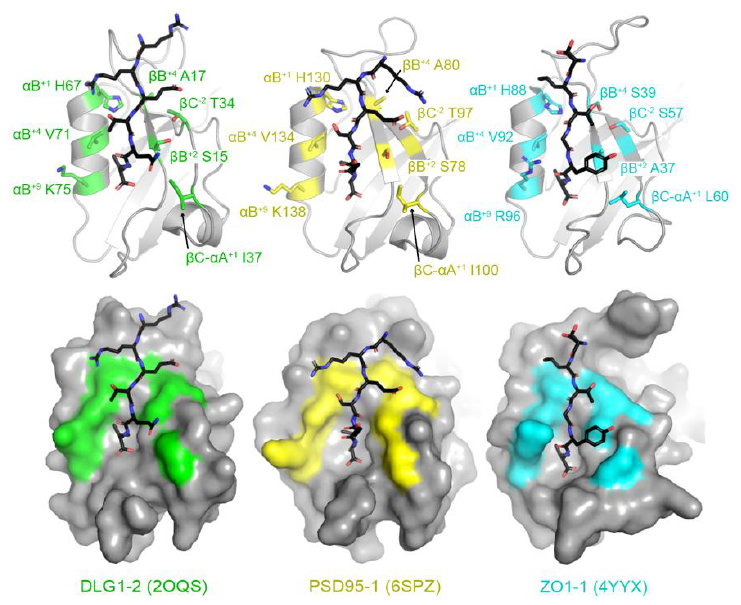
Figure 2. Identification of peptide-binding cleft residues in DLG1 PDZ2 (or DLG1-2, PDB ID 2OQS, green), PSD95-1 (6SPZ, yellow), and ZO1-1 (4YYX, cyan). Proteins are shown in both cartoon (top) and surface representations (bottom) with bound peptides in black sticks and colored by heteroatom (N = blue, O = red). The peptide-binding cleft residues used in this analysis are represented as side chain sticks and are colored by heteroatom or monochrome, respectively, and labeled. DLG1-2 is bound to a peptide of the HPV18 E6 oncoprotein (sequence: RRETQV) [61]. PSD95-1 is bound to a peptide with sequence RRESEI [62]. ZO1-1 is bound to the Claudin2 C-terminal tail (SLTGYV) [63].